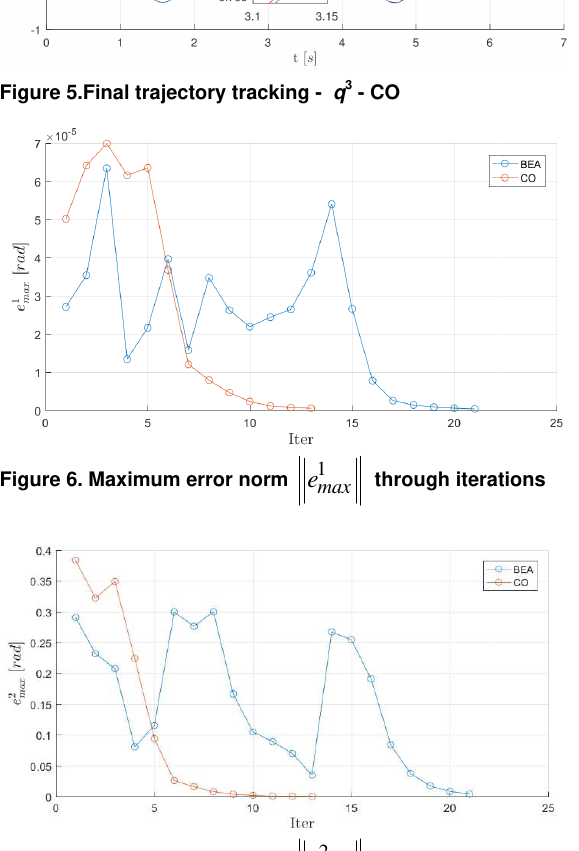
Figure 7. Maximum error norm